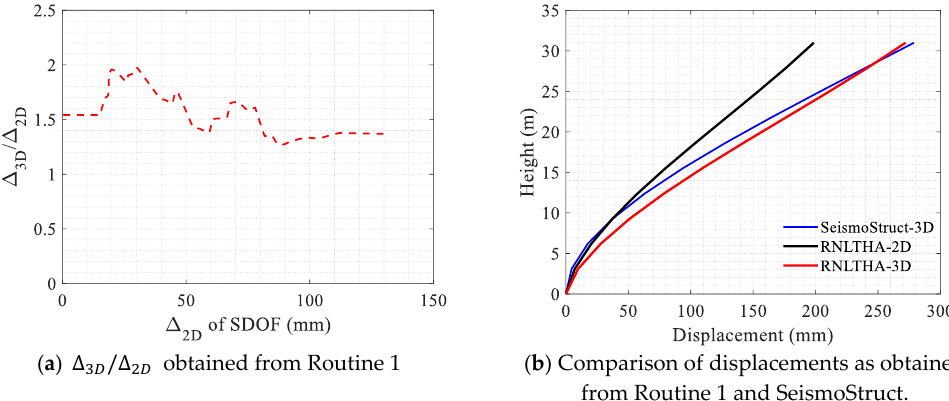
Figure 8. Comparison of the seismic demand as obtained from Routine 1 (RNLTHA-2D and 3D) with SeismoStruct-3D.